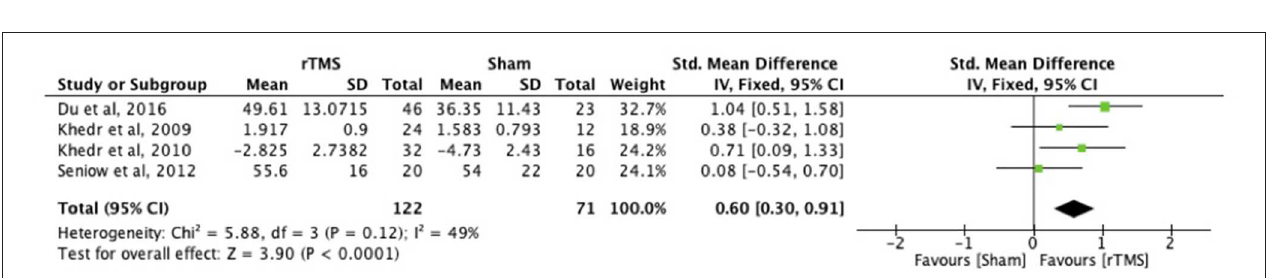
FIGURE 4 | Effects of rTMS on the ICF Activity domain, comparing different treatment onset times. Estimates of effect size are shown with 95% CIs. The standardized mean difference (SMD) and 95% confidence intervals (CIs); No studies within 3–6 months post-stroke subgroup; ICF Activity measures: Jebsen Taylor Test, Action Research Arm Test, and Wolf Motor Function Test.